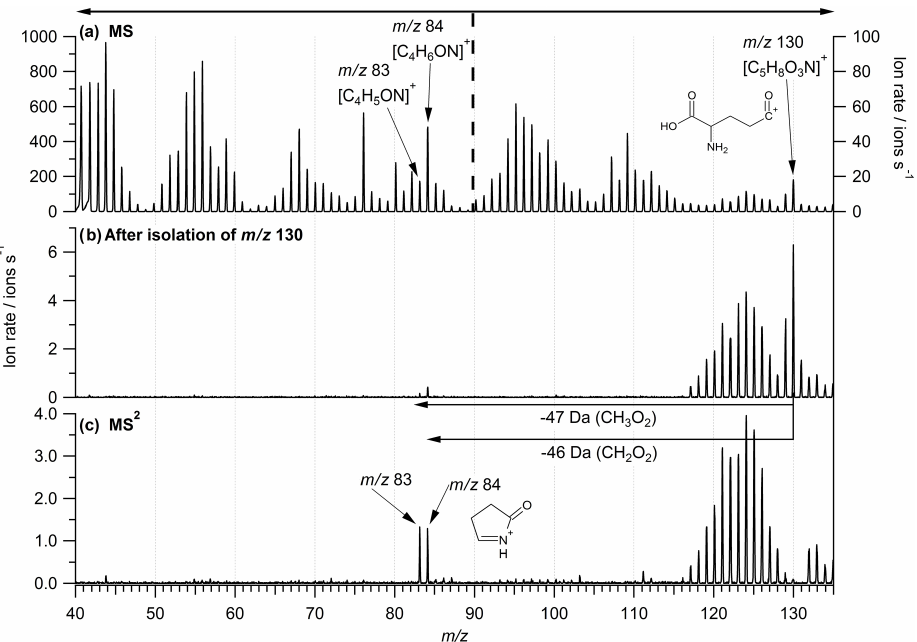
Figure 4. MS 2 study on glutathione. Shown are the “classic” MS (a) and the mass spectrum acquired after isolating (b) and fragmenting (MS 2 , c ) m/z 130. The signal in (c) in the m/z range ∼ 115–130 originates from ions remaining after the isolation step (b) . The dashed vertical line in panel (a) divides the m/z ranges for which the left/right y axes are used,